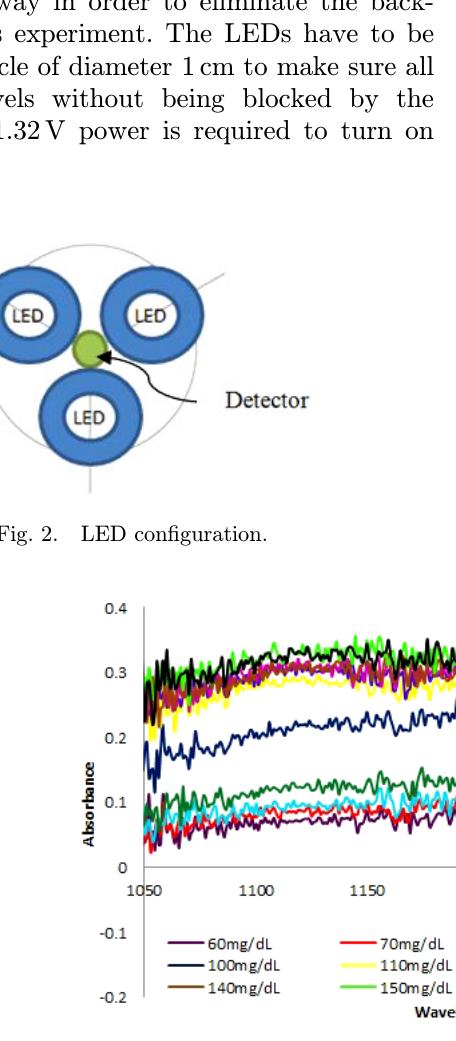
Fig. 3. Absorbance spectrum with various glucose